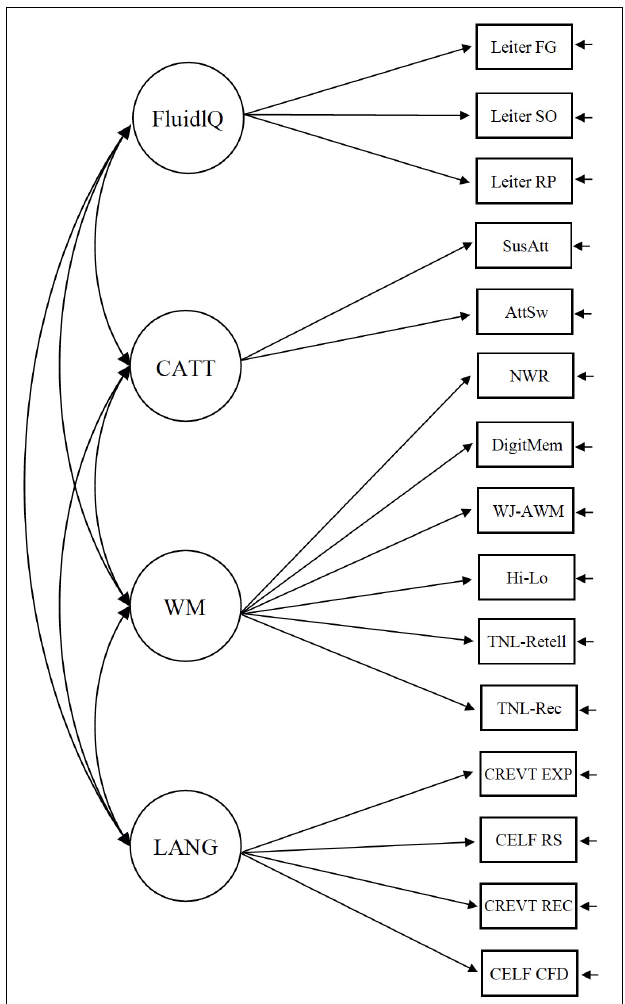
FIGURE 3 | A four-factor conceptual model in which the LTM-LK measures were embedded in the working memory latent